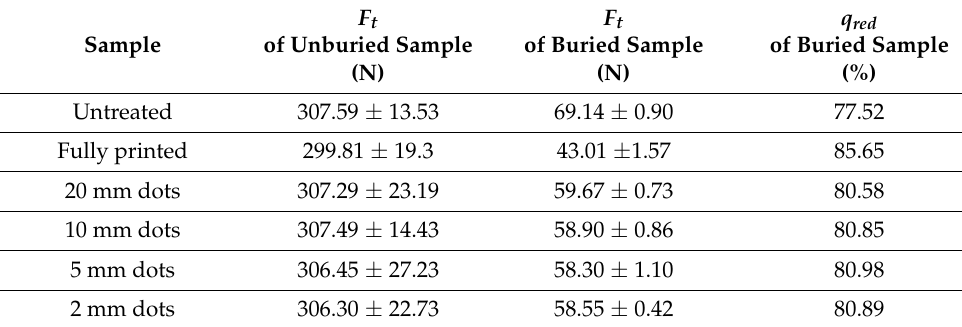
Table 4. Tensile strength reduction of buried samples.